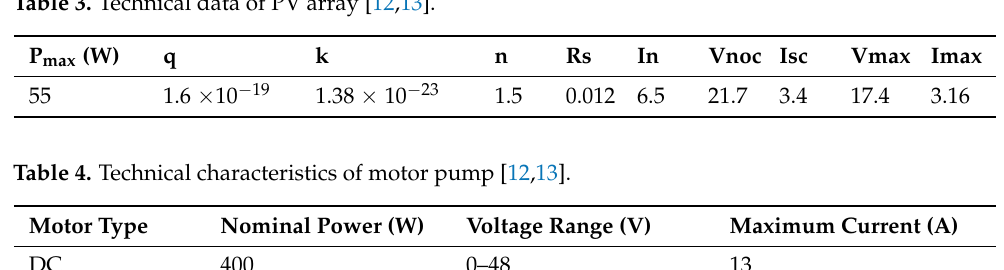
Table 3. Technical data of PV array [12,13].